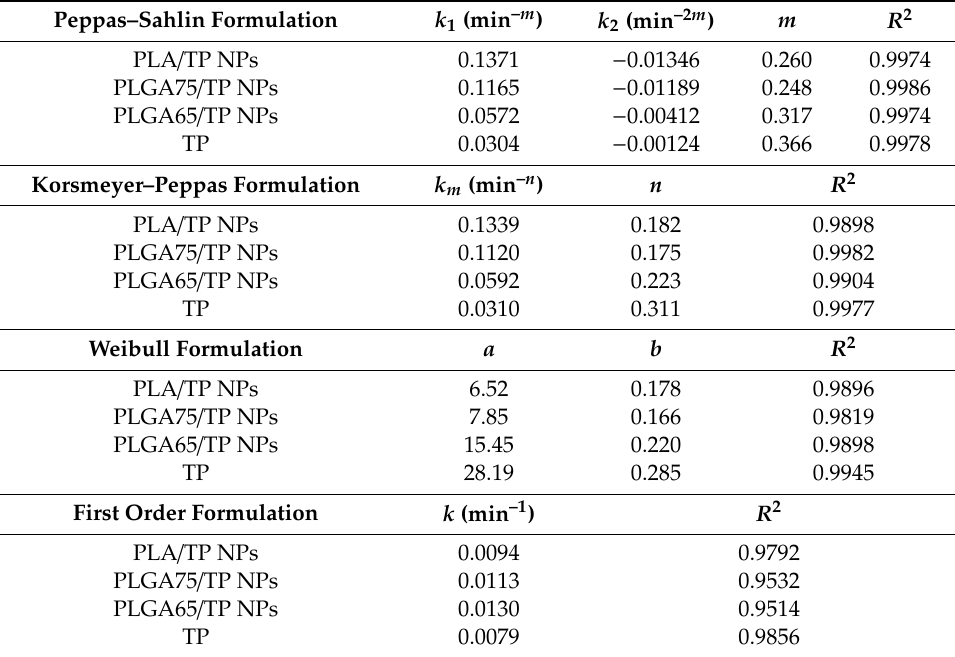
Table 2. Determined parameters of the TP release by fitting several kinetic